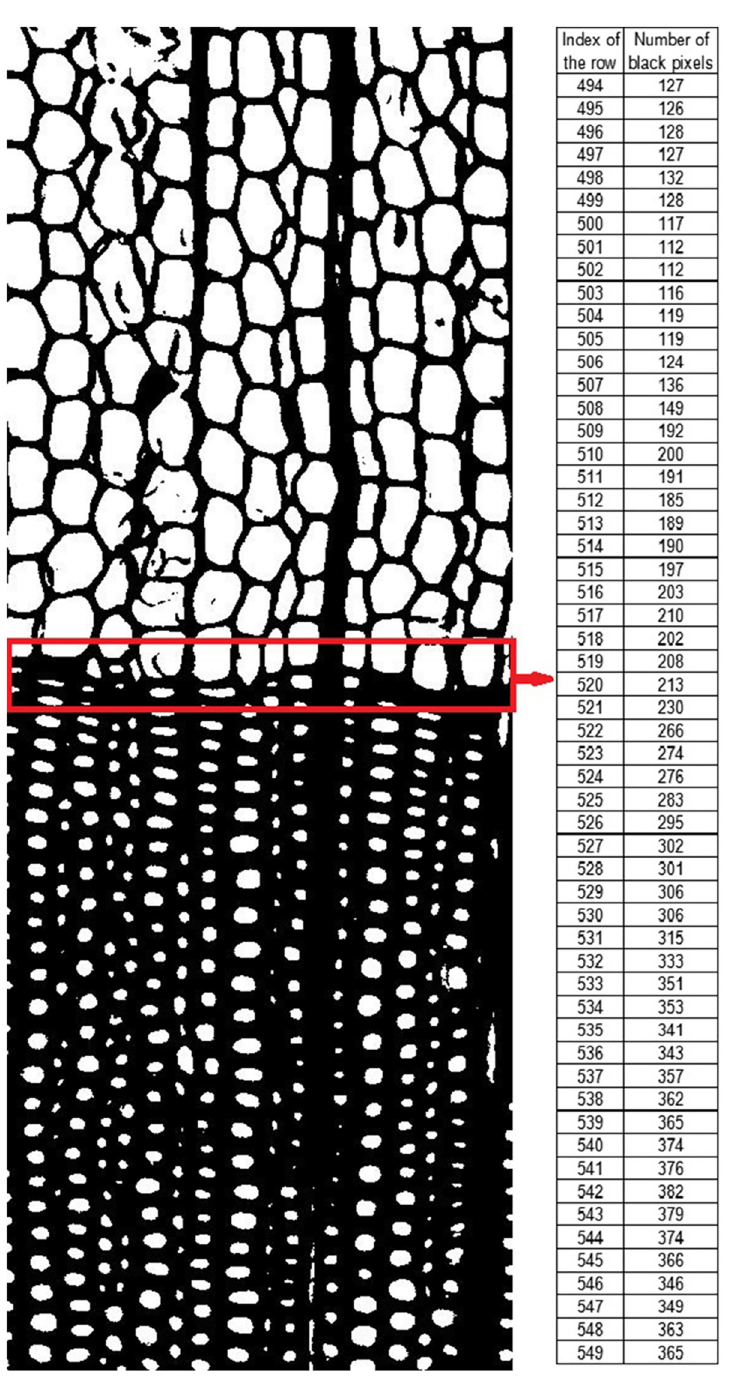
Fig 7. An example of counting black